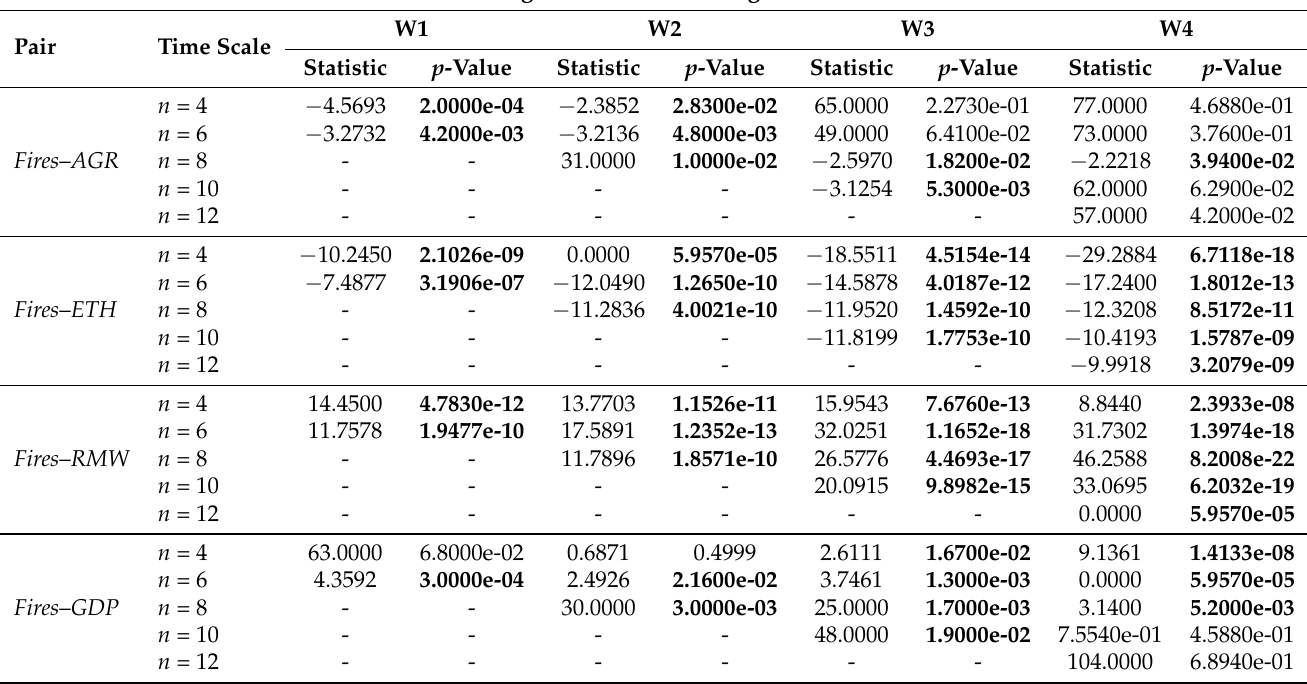
Table 5. The significance (contagion) test of ∆ ρ DCCA for W1 to W4. Significance level of 95% rejects the null hypothesis of ∆ ρ DCCA = 0), i.e., p -value < 0.05 (highlighted in